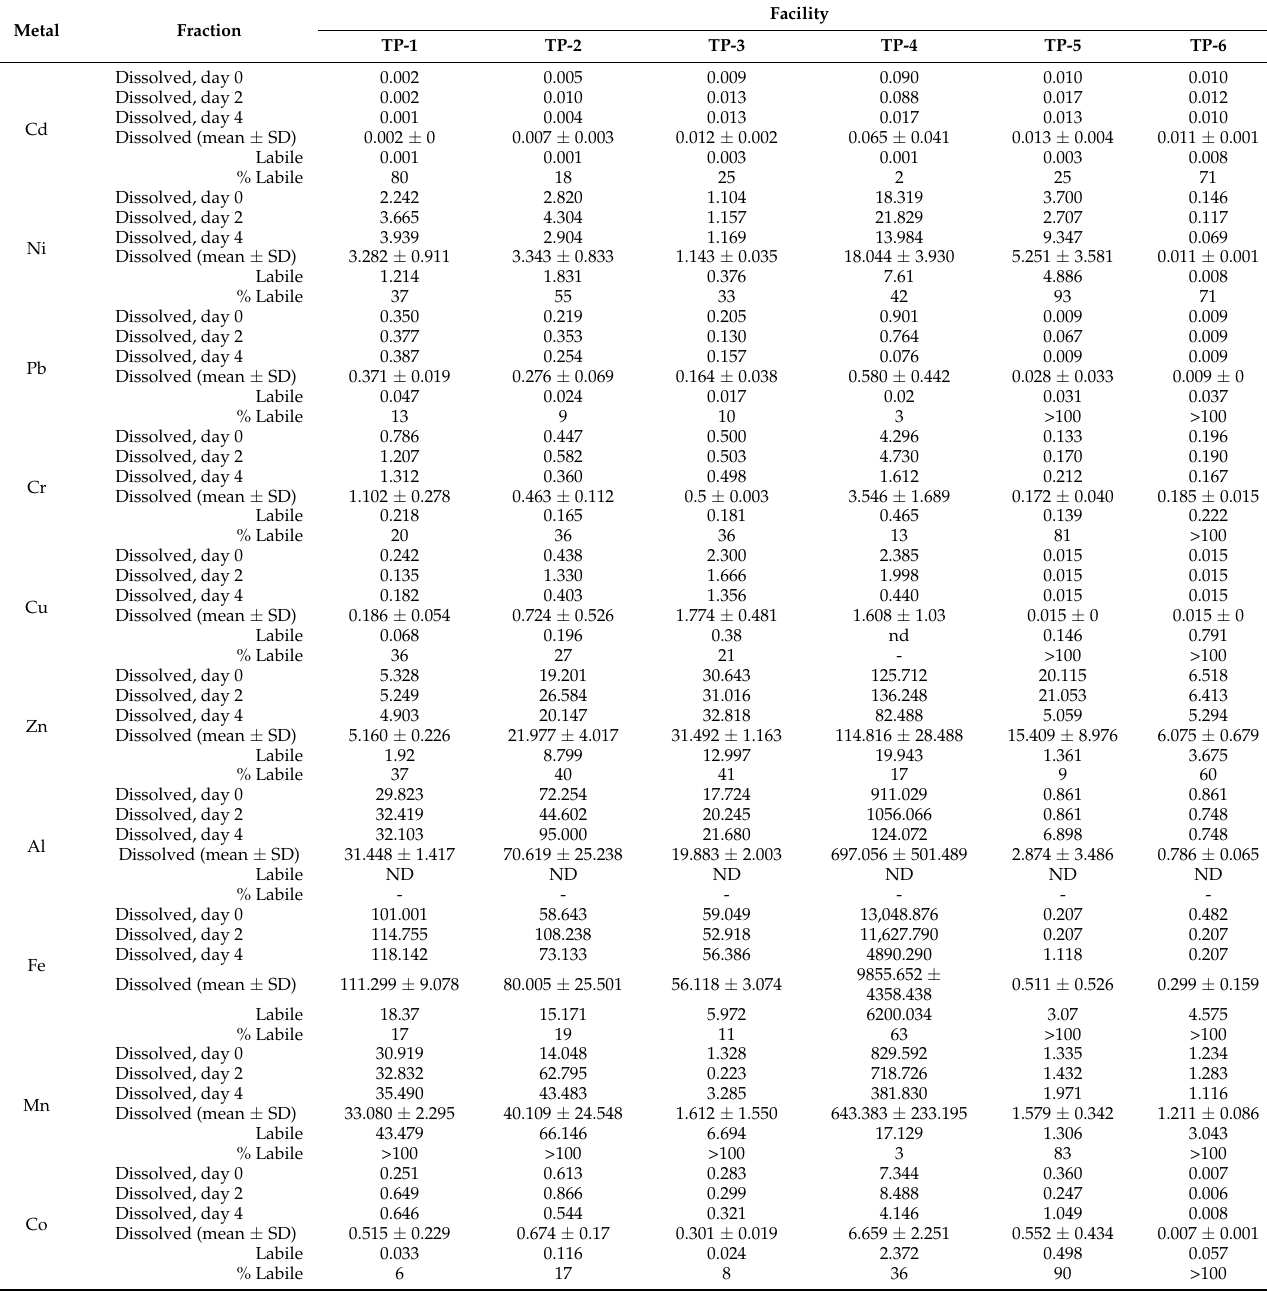
Table 2. Concentrations of total dissolved (day 0, day 2, day 4 and mean ± SD values in µ g · L − 1 ) and dissolved labile metals (mean values of the 3 replicates in µ g · L − 1 ) determined in the final effluent of each facility. The percentage (%) of the labile dissolved fraction per the total dissolved is also shown for every